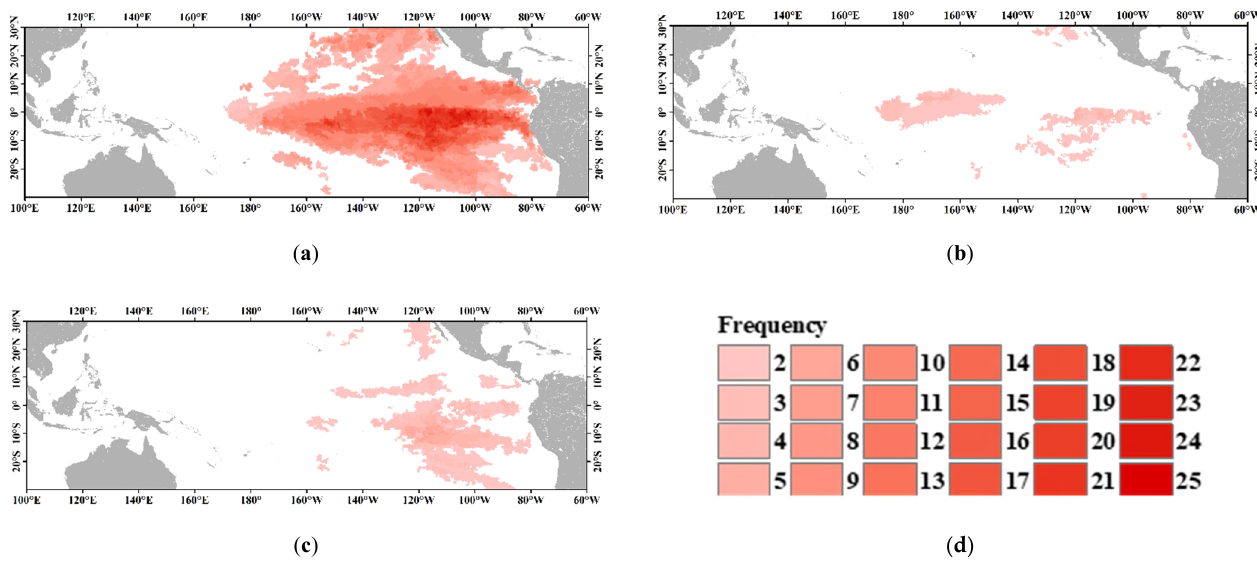
Figure 12. Spatial frequencies of the evolution relationships of warm process objects of SSTA during EP ENSO. ( a – d ) are development, merging, splitting, and legend.